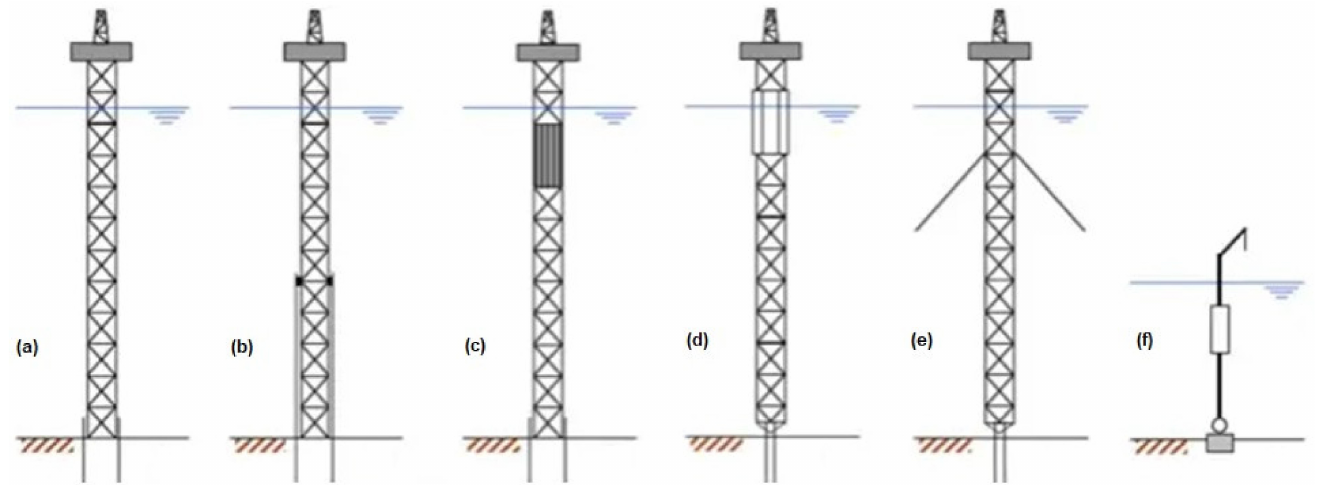
Figure 15. Cross-section of different concepts of compliant towers used in the oil and gas indus- try, showing ( a ) “dumb” tower, ( b ) compliant piled tower, ( c ) compliant tower with ‘mass trap’, ( d ) buoyant tower with flex joint, ( e ) guyed tower with flex joint, and ( f ) articulated